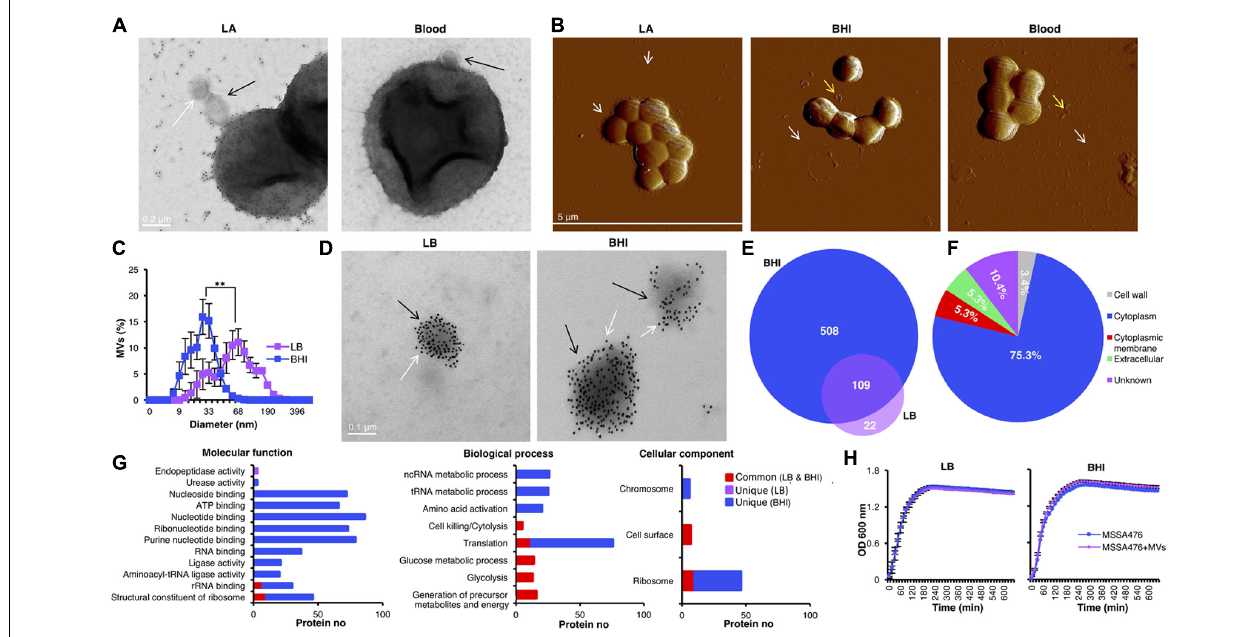
FIGURE 1 | The size and protein cargo of S. aureus -derived MVs were markedly different depending on growth conditions. (A) TEM-immunogold analysis of MV-generation on S. aureus MSSA476 (black arrow) grown on LA and blood agar plate. Gold particles (white arrows) indicate the presence of peptidoglycan/peptidoglycan-precursors. The scale bar is shown. (B) Atomic force micrographs of S. aureus MSSA476 cultivated on LA, BHI- and blood agar plates. Arrows indicate MVs on the bacterial surface and the released MVs. The scale bar is shown. (C) The average size distribution of MVs was determined using dynamic light scattering. The data are expressed as mean ± SEM (standard error of the mean) of four independent measurements performed on independent samples. (D) TEM-immunogold labeling of peptidoglycan/peptidoglycan-precursors in purified vesicles (black arrows) obtained from S. aureus MSSA476 grown in BHI and LB purified by flotation through an OptiPrep density gradient. Gold particles (white arrows) indicate the presence of peptidoglycan/peptidoglycan-precursors. Scale bars are shown. (E) S. aureus -derived vesicles from MSSA476 grown in LB and BHI were purified by flotation through an OptiPrep density gradient. Venn diagram illustrates common and unique proteins associated with MV identified using LPI/in-solution approaches. (F) Localization of the MV-associated proteins shown as the percentage in a pie chart. (G) Histograms representing the distribution of identified vesicular proteins according to their molecular functions, role in biological processes and cellular components. (H) Supplementation of MVs (20 µ g of total MV, i.e., 0.1 µ g/ µ l) in the culture media did not influence bacterial growth in LB media (left panel) or BHI (right panel). Data represent as the mean ± SEM of three independent experiments. The significance is indicated by asterisks ( ∗ ): ∗∗ P ≤